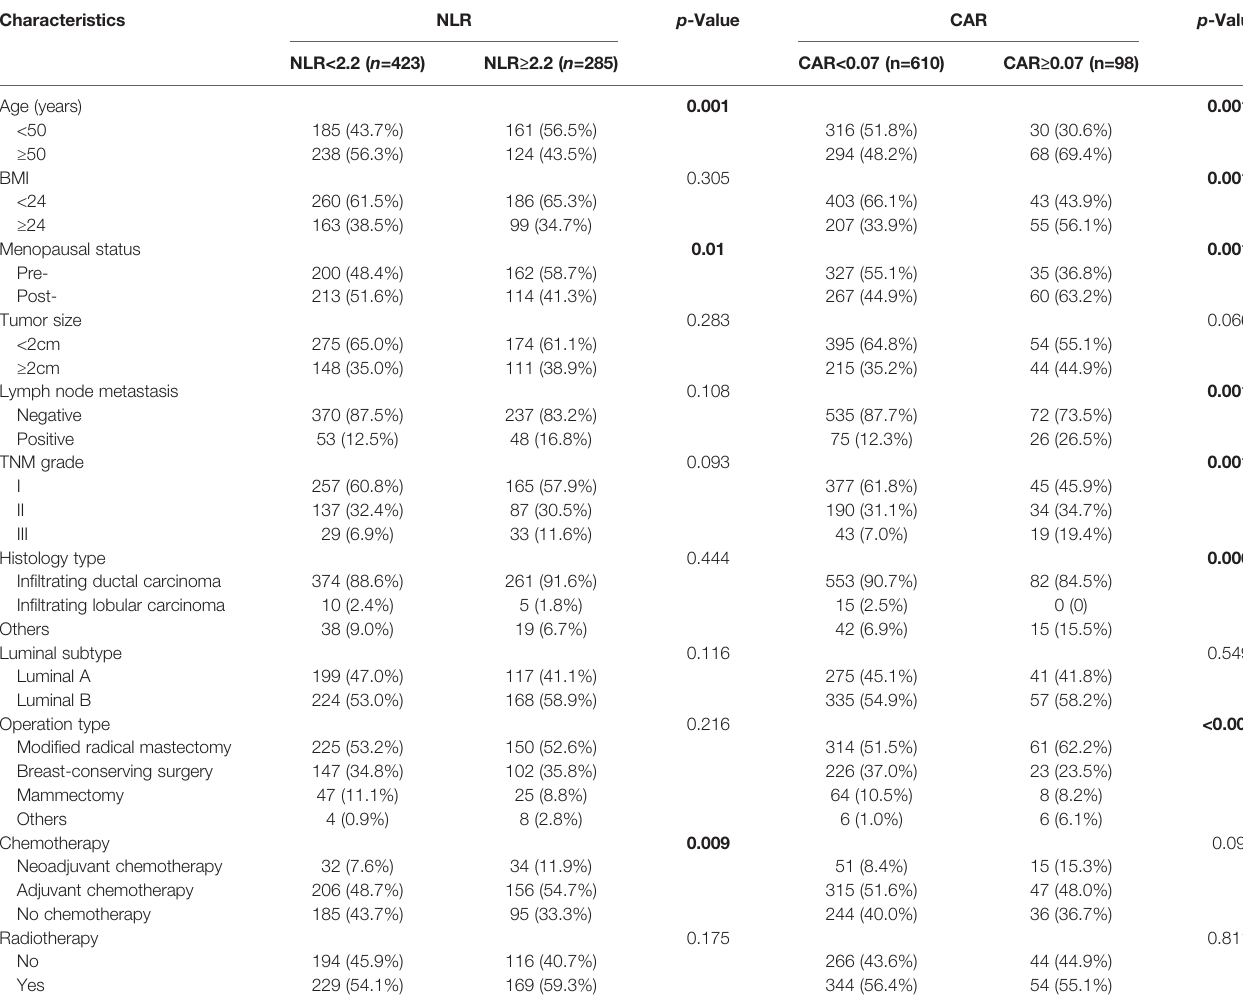
TABLE 3 | Clinicopathological characteristics of breast cancers according to neutrophil-to-lymphocyte ratio (NLR) or c-reactive protein/albumin ratio (CAR) levels.